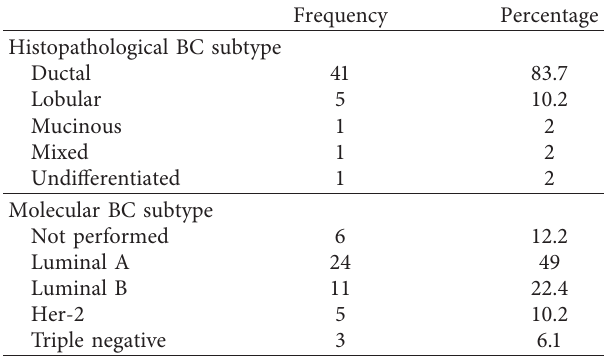
Table 1: Histological and molecular BC